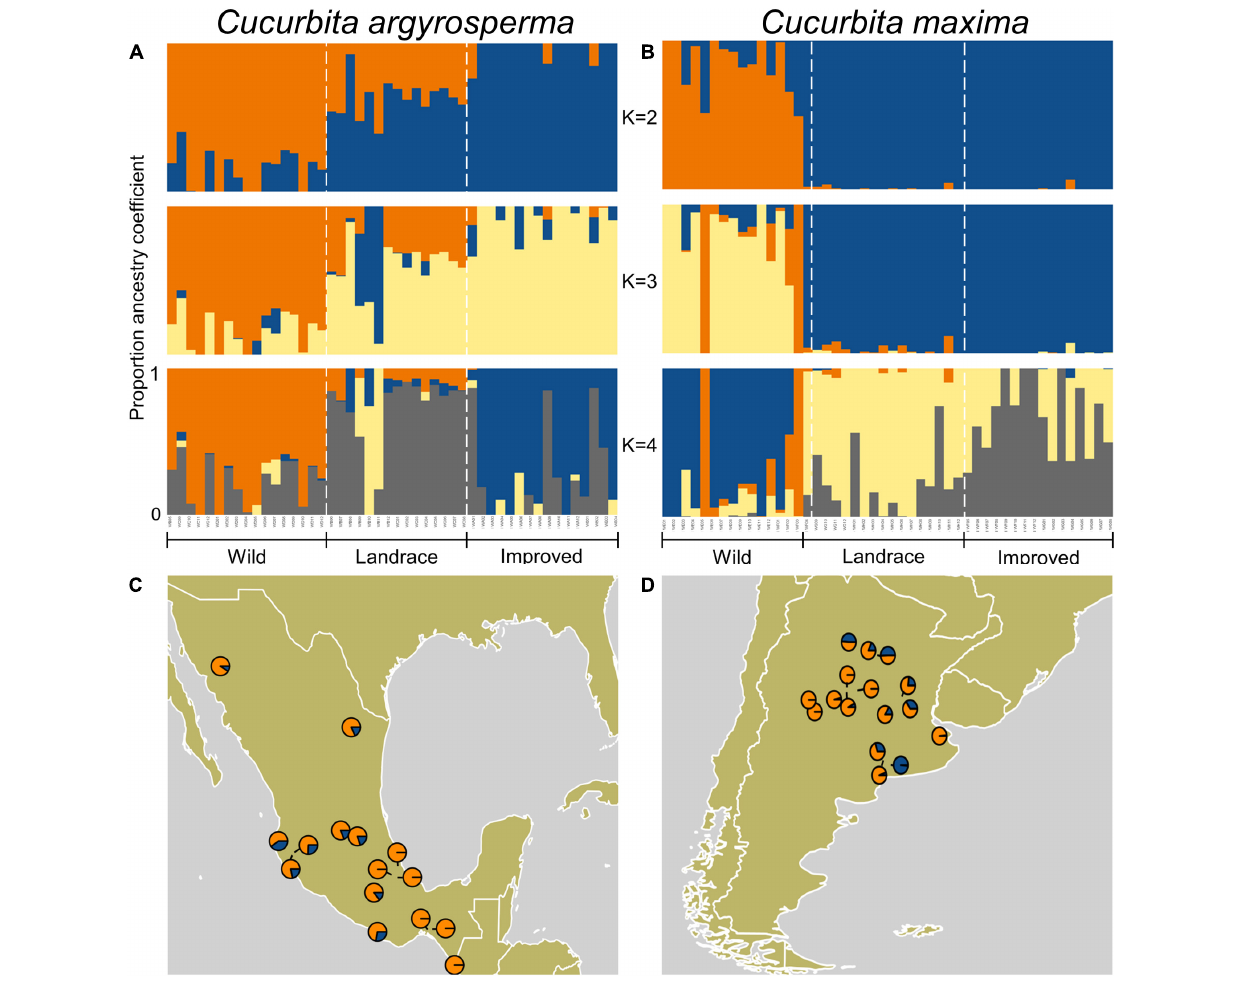
FIGURE 2 | Bayesian clustering (STRUCTURE) results for C. maxima and C. argyrosperma and ancestry coefficients mapped onto sampling localities. (A,B) Bayesian clustering (STRUCTURE, K =2–4) of (A) C. argyrosperma accessions and (B) C. maxima accessions. (C,D) Ancestry coefficients mapped onto sampling localities for wild accessions of (C) C. argyrosperma and (D) C. maxima . Colors correspond to ancestry-coefficient colors in panels (A,B)